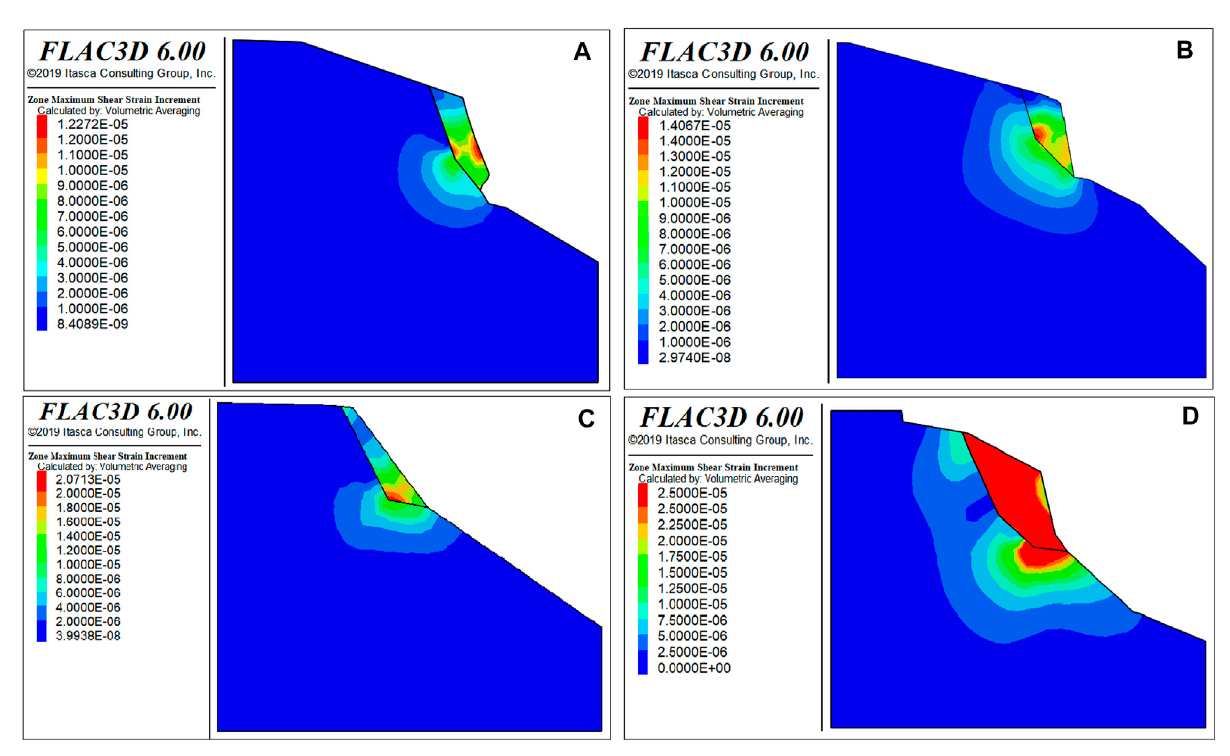
FIGURE 7 Shear strain of unstable rock under the limit state. (A) W1. (B) W2. (C) W6. (D)